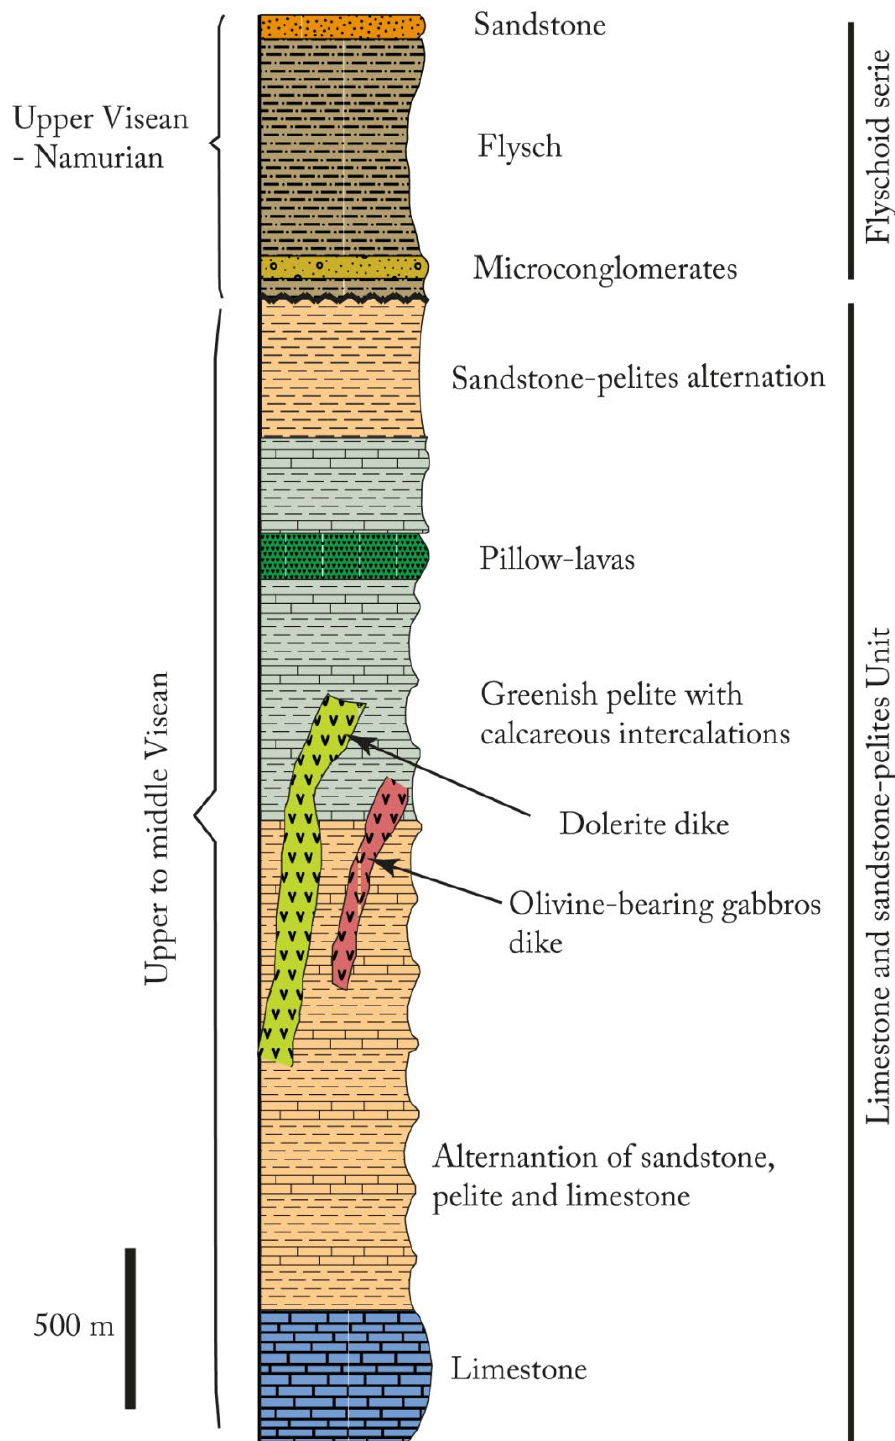
Figure 4. Synthetic lithostratigraphic column of the NNE Achemmach.